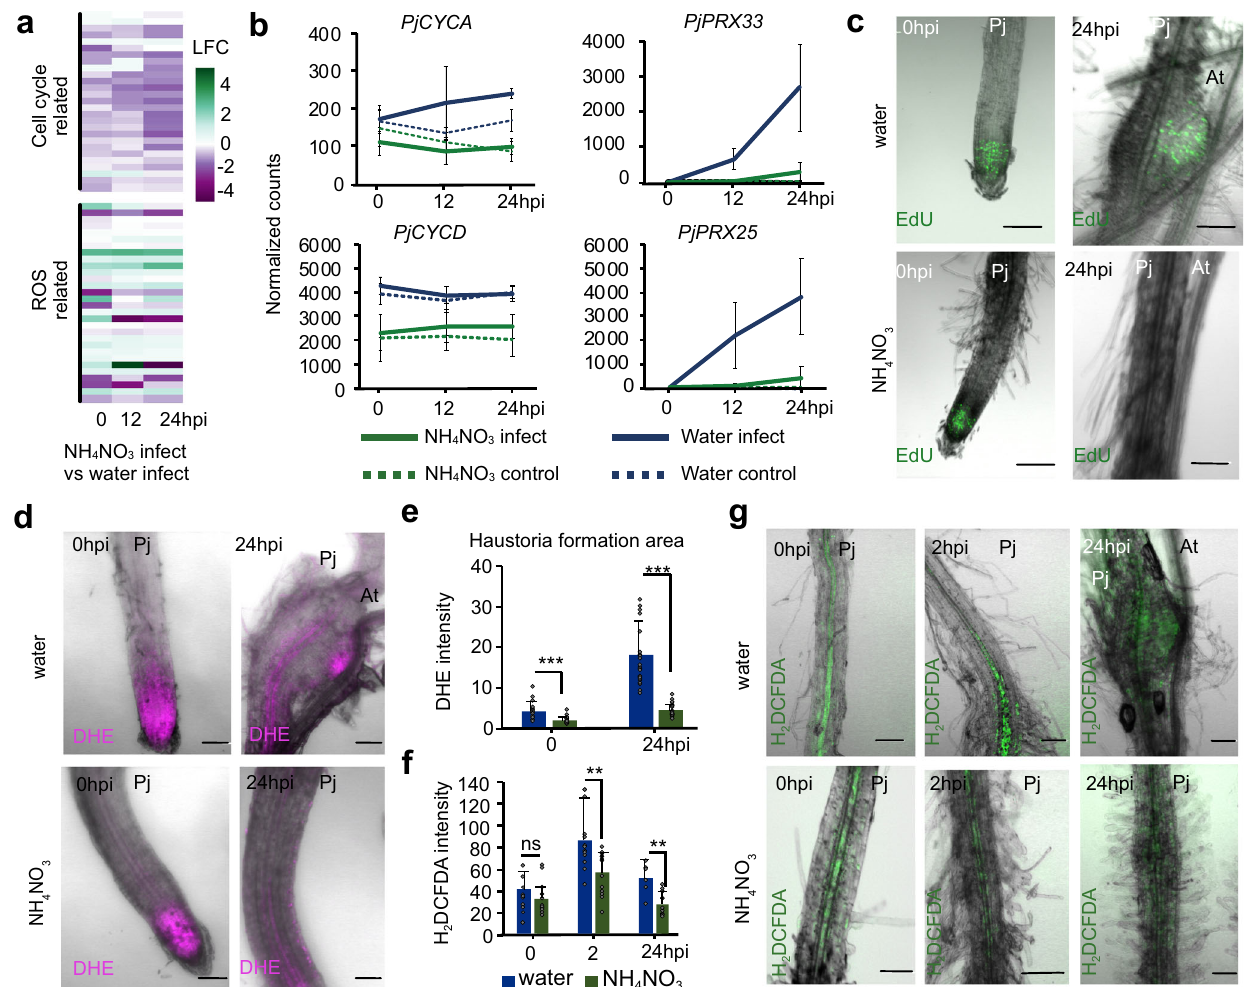
Fig. 4 NH 4 NO 3 reduces ROS accumulation and cell division in P. japonicum . a Heatmap of 27 cell cycle and 30 ROS related P. japonicum genes in NH 4 NO 3 infect compared to water infect RNAseq datasets. b Normalized P. japonicum counts of PjCYCA, PjCYCD, PjPRX33, PjPRX25 over three time points shown for control and infect in the NH 4 NO 3 and water treatment, bars represent mean ± SD. c , d , g Representative images of P. japonicum in vitro Arabidopsis Col-0 infections with water or 10.3 mM NH 4 NO 3 at 0, 2 and 24 h post-infection (hpi) stained with EdU (c), dihydroethidium (DHE) (d) or 2 ′ ,7 ′ - dichlorodihydro fl uorescein diacetate (H 2 DCFDA) ( n = 20 plants per treatment per replicate, 2 replicates). Scale bars 100 μ m. e , f DHE at 0 and 24 hpi ( n = 22, water 0 hpi n = 17) and H 2 DCFDA at 0, 2, 24 hpi ( n = 12, 24 hpi water treatment n = 6) intensity in the P. japonicum haustorium formation area after water infect or NH 4 NO 3 infect (mean ± SD; Comparisons to water treatments. Asterisks represent * P < 0.05, ** P < 0.001, *** P < 0.0001, Student ’ s t test, two tailed). Source data